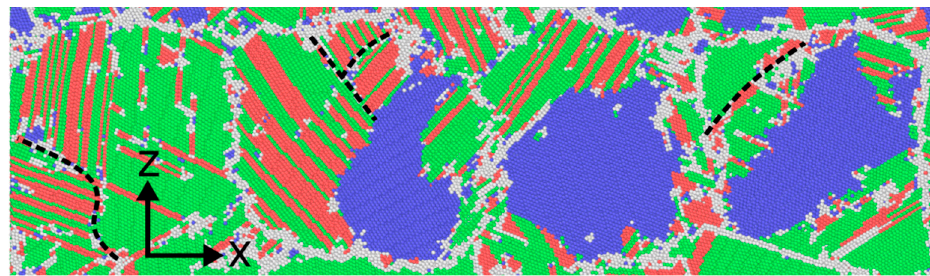
Figure 10. Cross-section of the medium-grained layer by the XZ plane at the strain 9.25%. Atoms with bcc, fcc, hcp and uncertain nearest neighbor symmetry are shown in blue, green, red, and light gray, respectively. Fragment boundaries are marked off by dashed lines.